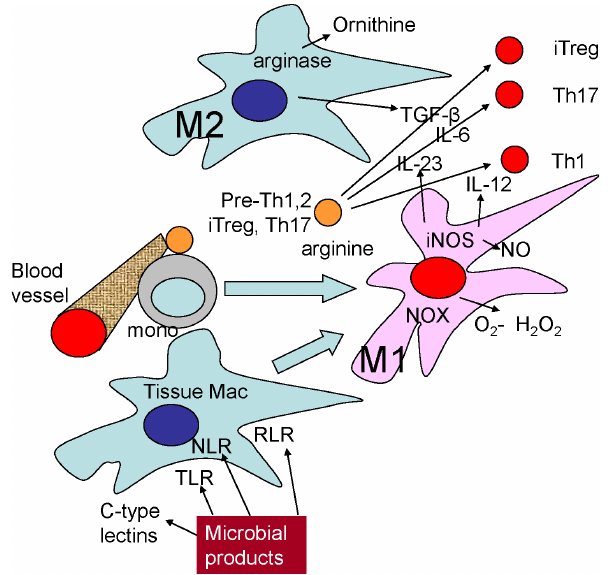
Figure 2. Pathogen sensors and cytokine environment. Tissue macrophages have a natural bias toward M2 (express arginase, produce TGF- β ). T cells in this environment are likely to commit to the iTreg lineage. If tissue macrophages sense the presence of pathogens through their TLRs, NLRs, RLRs (see definitions in text) or C-type lectin receptors, they convert to M1 (express iNOS, produce IL-12, IL-23, upregulate MHC-II and CD86). M1 differentiation also induces expression of chemokines that attract more monocytes from the circulation, which have a propensity to become M1-polarized after transmigration. T cells receiving a second touch in this environment are likely to commit to Th1 if IL-12 dominates or Th17 if IL-23 dominates. The tissue environment producing Th2 cells is not well understood, but may involve M2